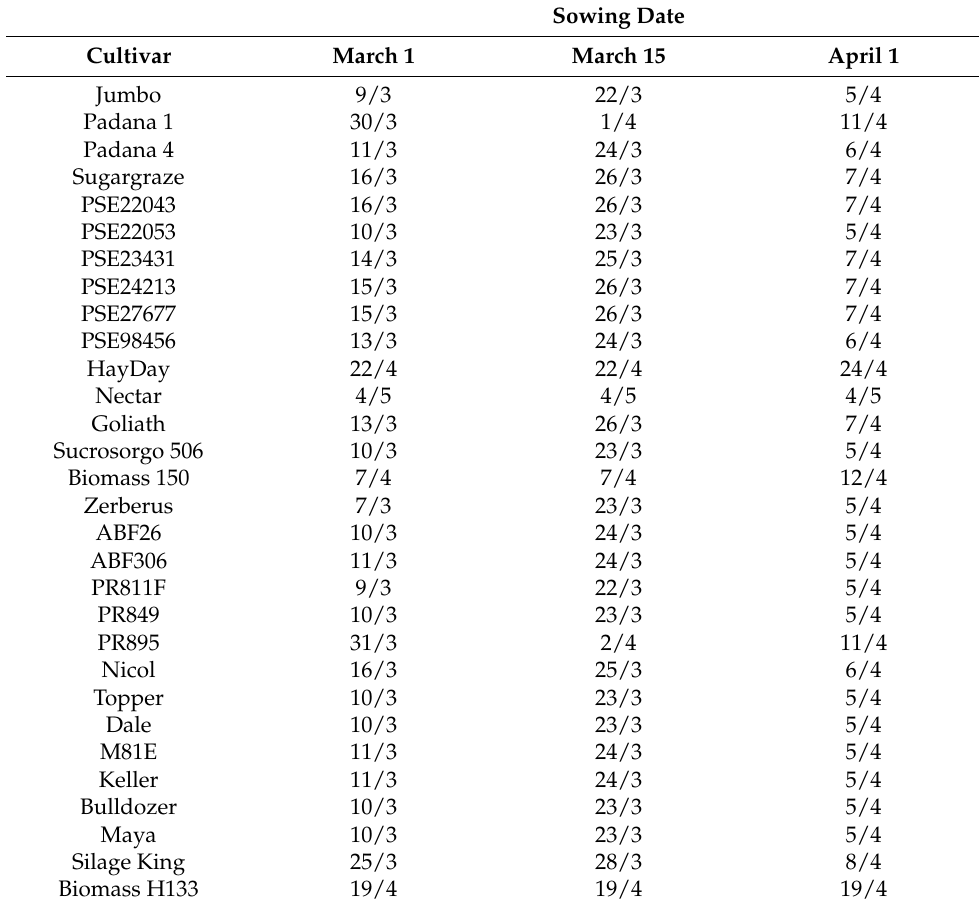
Table 7. Date of occurrence of 50% seed germination in the field in relation to three hypothetical early sowing dates, as predicted by thermal